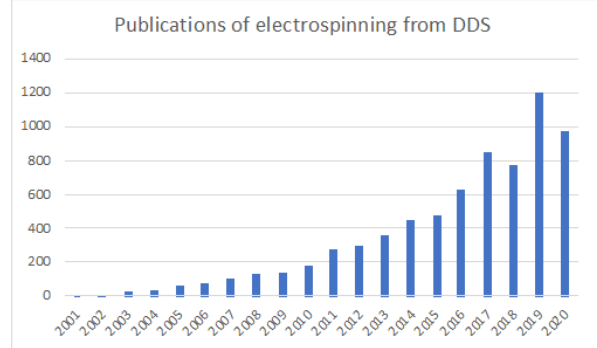
Figure 3: The annual number of scientific publications about elec- trospinning materials for drug delivery systems (Data analysis was done using science direct database using the words electrospinning and drug delivery, July 15,